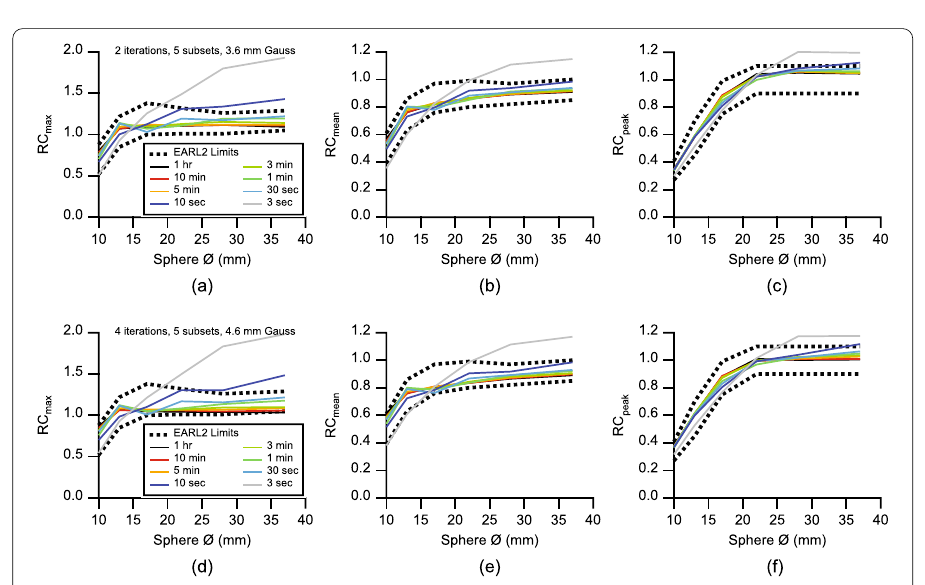
Fig. 7 Upper row: Recovery curves calculated from RC max ( a ) RC mean ( b ) and RC peak ( c ) for different exposures resulting from 2 iterations, 5 subsets, and 3.6 mm Gauss FWHM with respect to EARL2 limits. Lower row: recovery curves calculated from RC max (d) RC mean ( e ) and RC peak ( f ) for different exposures resulting from 4 iterations, 5 subsets, and 4.6 mm Gauss FWHM with respect to EARL2 limits. Legend applies to all